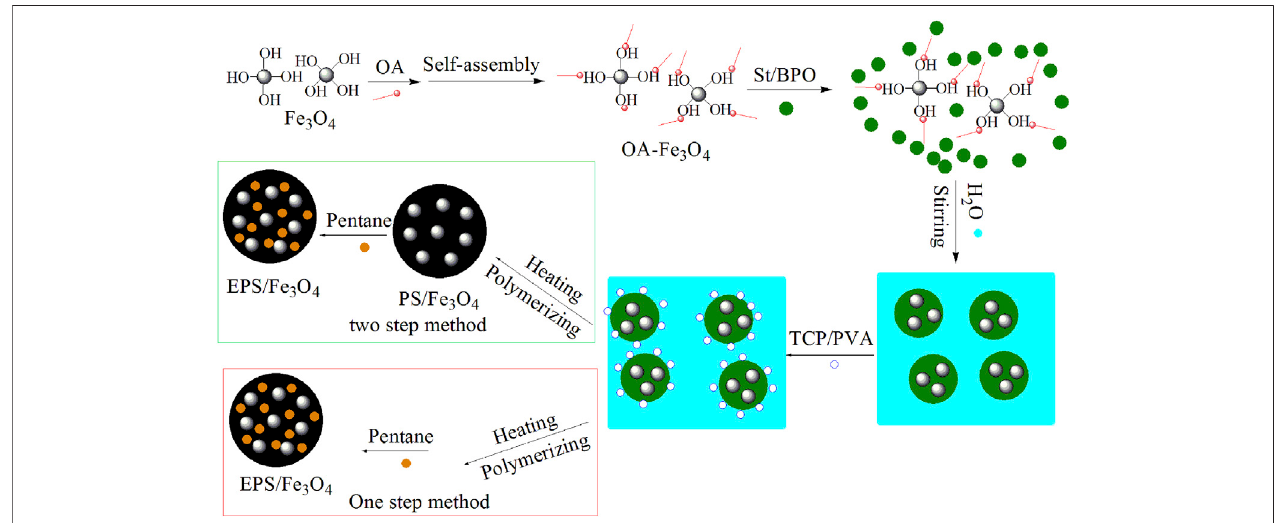
FIGURE 1 | Schematic showing the synthesis of colorized PS/Fe 3 O 4 beads and EPS/Fe 3 O 4 beads.